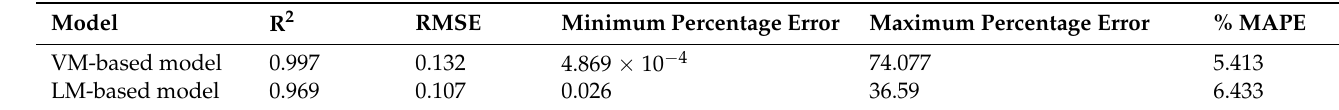
Table 3. Statistical parameters for the two